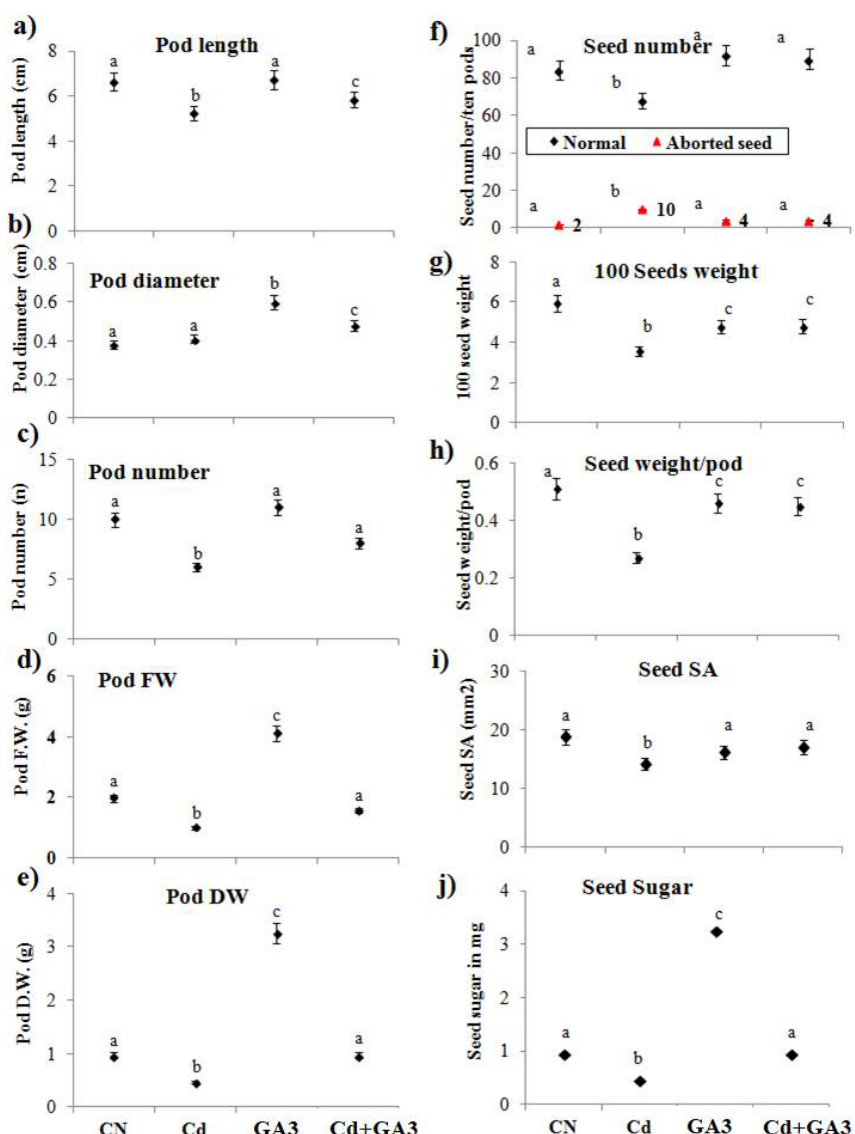
Figure 7. Effect of GA 3 with or without cadmium (Cd) stress on pod length ( a ), pod diameter ( b ), pod number/plant ( c ), pod fresh weight/plant (Pod FW, d ), pod dry weight (Pod DW, e ), normal and aborted seed number/ten pods ( f ), hundred seeds weight ( g ), seed weight/pod ( h ), seed surface area(SA) ( i ) and seed sugar ( j ) of mung bean plants grown in soil in pots at time of harvest. Control (CN), cadmium (Cd) stress, Cd+ gibberellins (GA 3 ), and GA 3 alone conditions. Data presented are means ± standard errors ( n = 10, biological replicates). Different letters (a, b, c) indicate significant differences from control in all combinations (Tukey’s test, p ≤ 0.05).